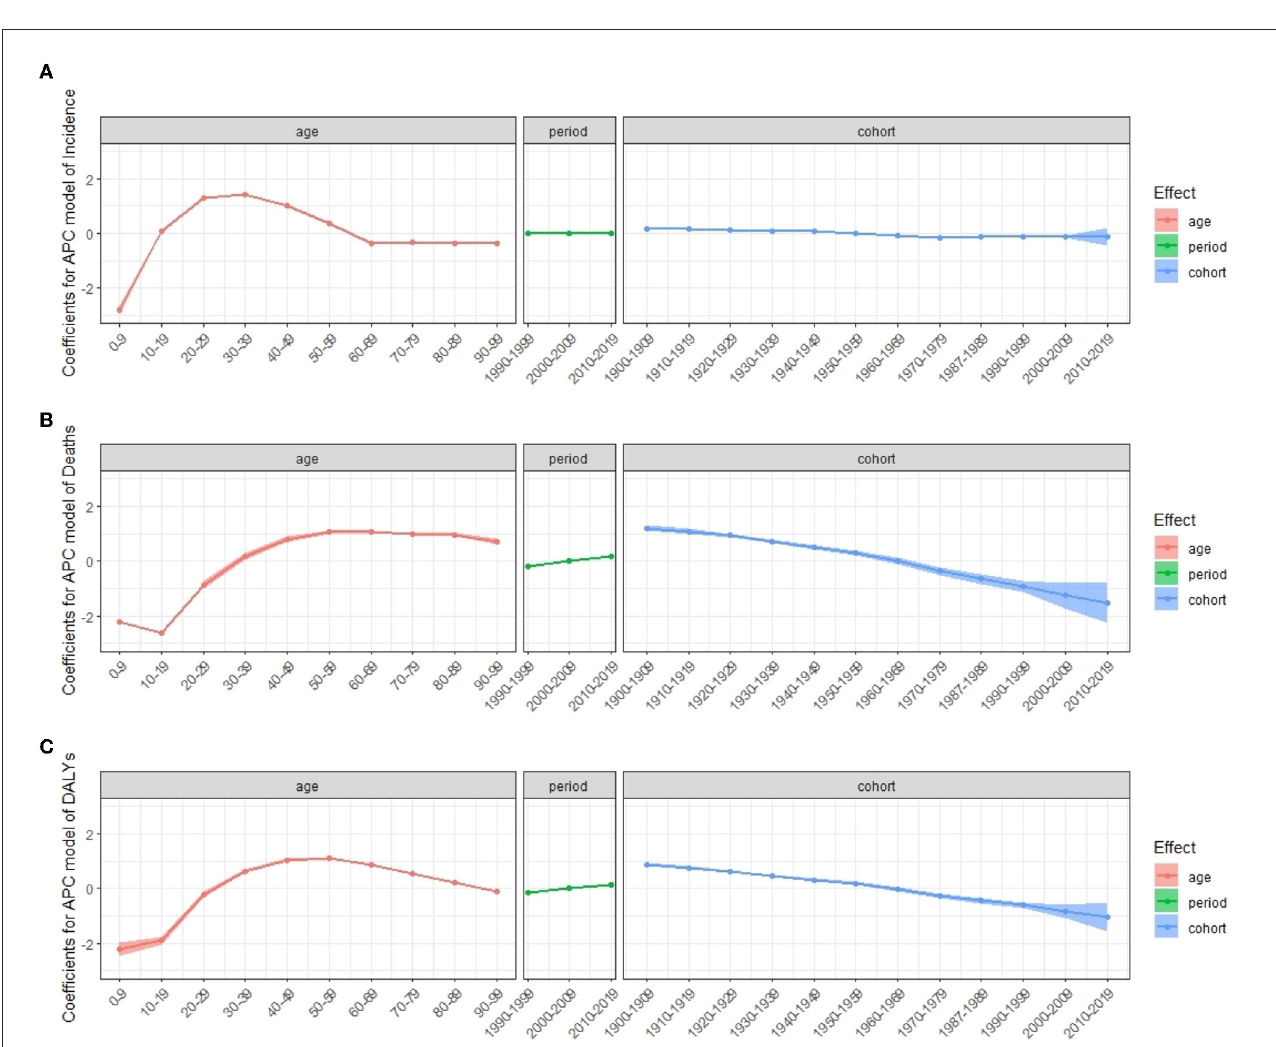
FIGURE6 Coefficients for APC model of multiple sclerosis incidence (A) , deaths (B) , and DALYs (C) from 1990 to 2019. Error bars represented the 95% confidence intervals. APC, age–period–cohort; DALYs, disability-adjusted life years.